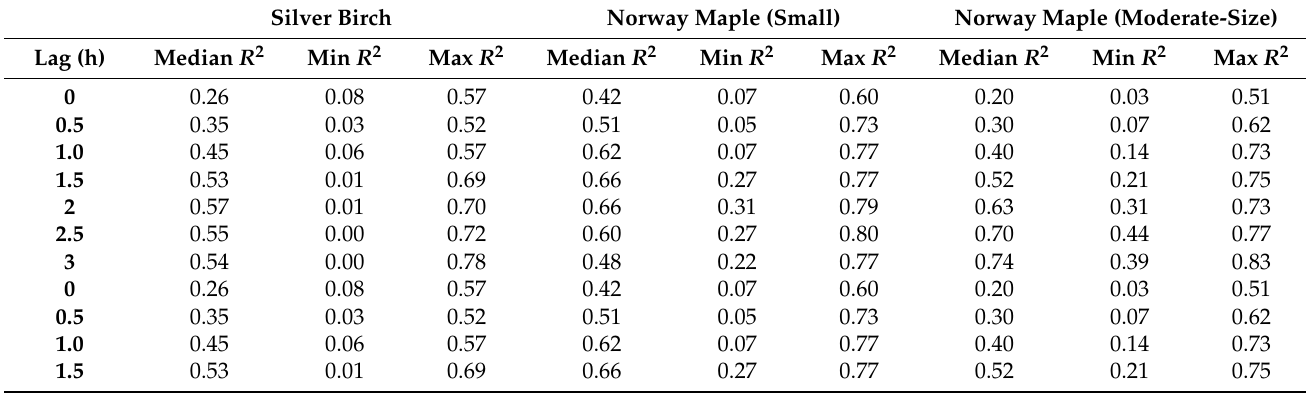
Table 4. Median, minimum (Min) and maximum (Max) of coefficient of determination ( R 2 ) of linear regression models between vapor-pressure deficit (VPD) and the overnight branch movements measured in August. Number of observed branches were 14, 13 and 17 for silver birch, small Norway maple and moderate-sized Norway maple, respectively. Characteristics of the trees are presented in Table 2. Silver Birch Norway Maple (Small) Norway Maple